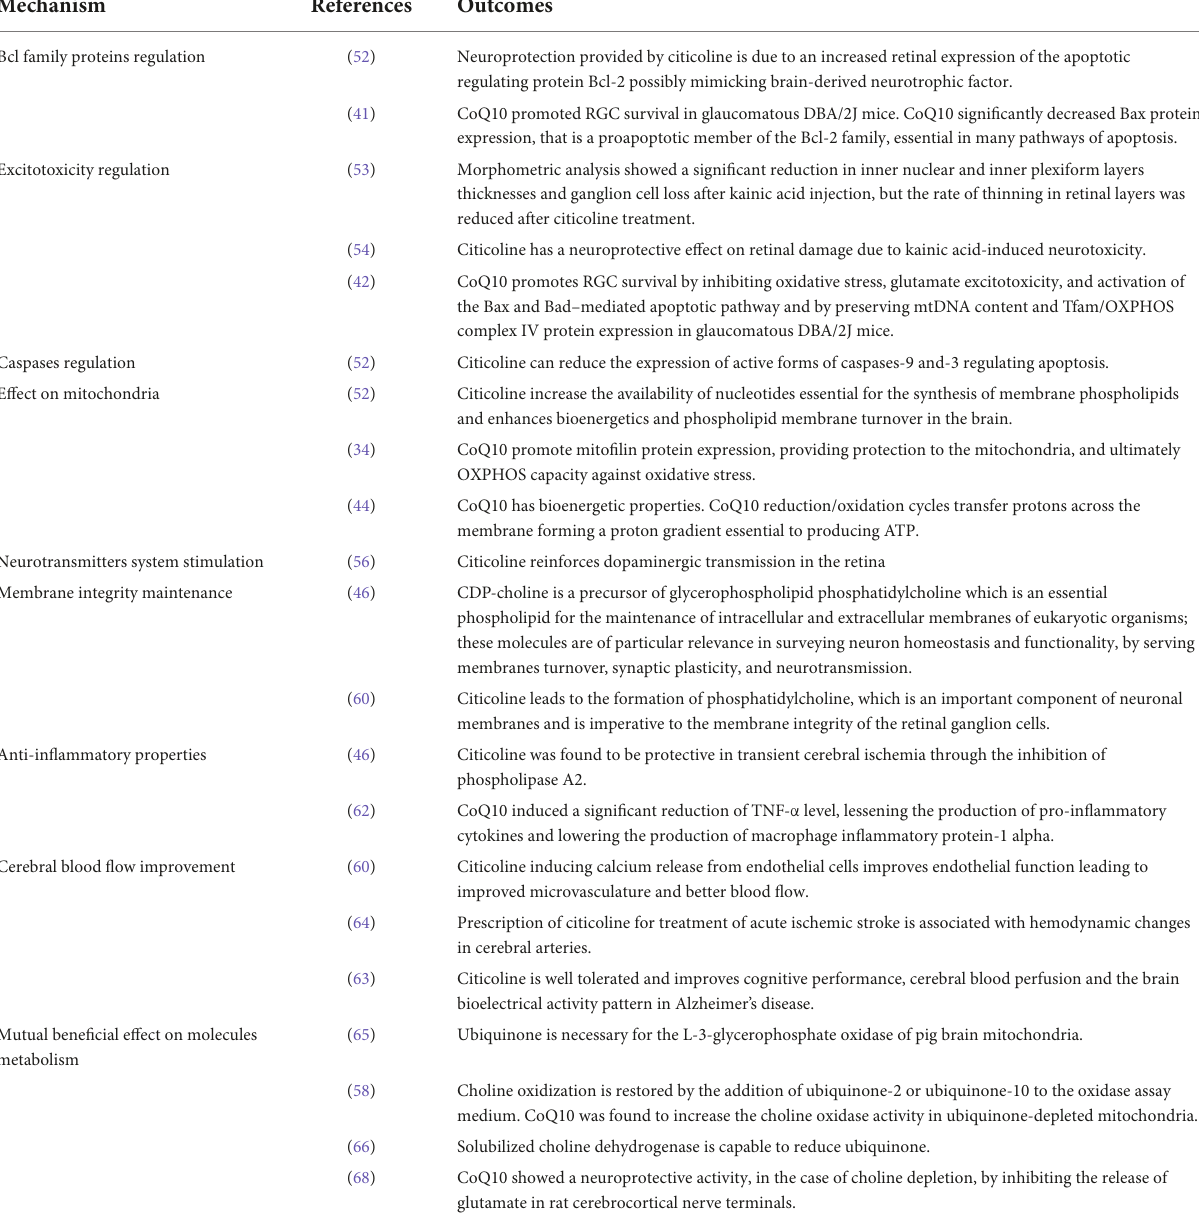
TABLE 1 Principal studies describing neuroprotective molecular mechanisms of coenzyme Q10 (CoQ10) and